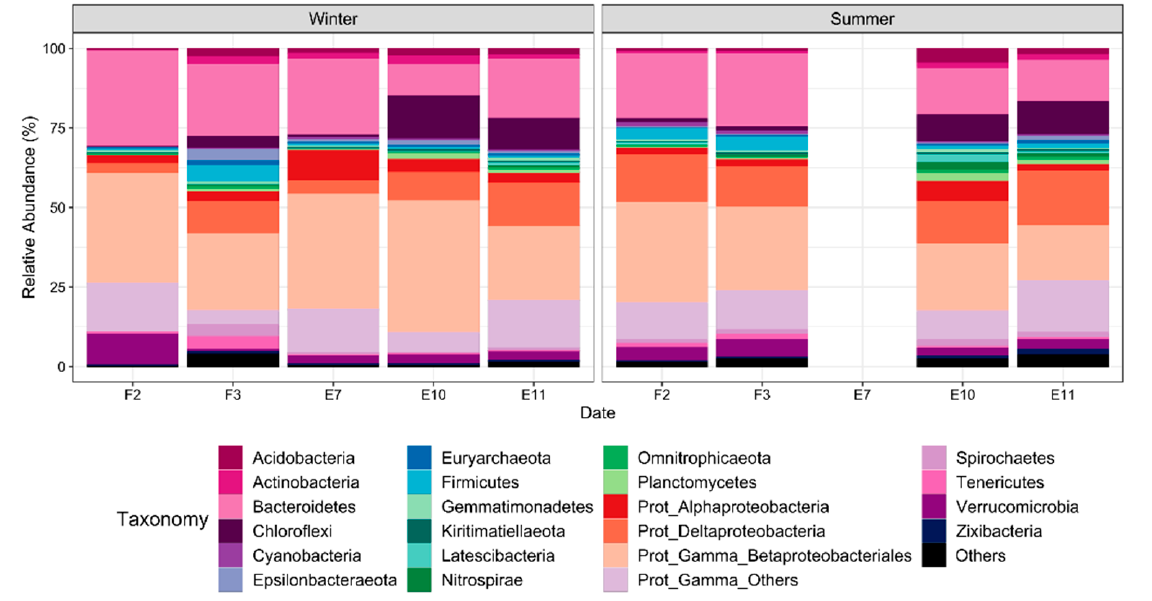
Figure 7. Taxa bar plot showed microbiome distribution from sediment at the phylum level during winter (left panel) and summer. Others correspond to phyla with relative abundance < %. Note that no sequencing data were available for E7 in summer.